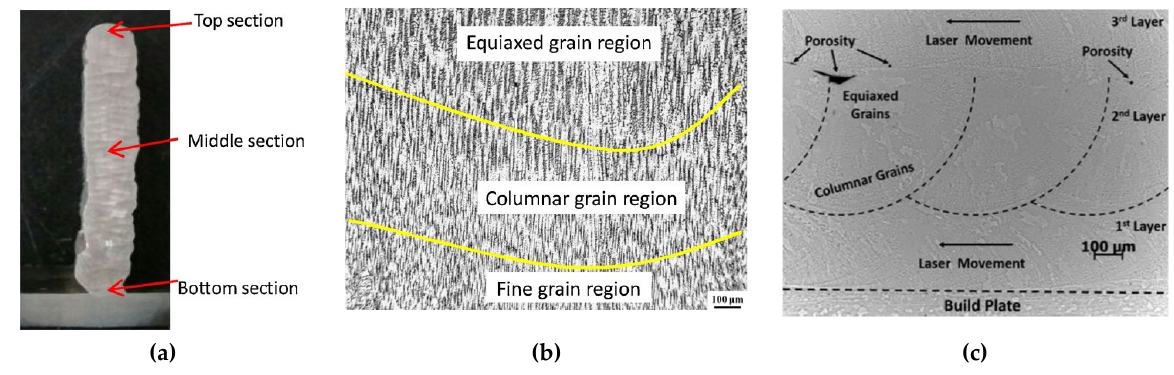
Figure 7. ( a ) Cross ‐ sectional microstructure and ( b ) microstructure differences along the height of the sample [83]; ( c ) traces of the melt bath and microstructure differences in it [84]. It was found that the predominantly columnar grains grew epitaxially in the direc ‐ tion of the temperature gradients (Figure 7a,b), which is inevitably related to the high cooling rate during fabrication. In [85], the EBAM ‐ fabricated samples were characterized by a predominantly austenitic structure with thin ferrite crystallites between the austenitic dendrites, similar to those shown in Figure 8b. The ferrite colonies had different morphol ‐ ogies—vermicular, cellular, lattice, or point ‐ like. The temperature gradient varied along the height of the fabricated sample, hence an inconsistent solid ‐ phase transformation oc ‐ curred, leading to differences in the microstructure. The columnar dendrites extended in the direction of the temperature gradient. An equiaxial structure prevailed in the upper layers. The difference in the microstructure in different layers can be explained by the solidification rate (V) and temperature gradient (G) during material melting and solidifi ‐ cation, where the G/V ratio determines the morphology (cellular/dendritic/equiaxial) [86]. The electron beam AM process uses an electron beam to heat and fuse metal filaments, so